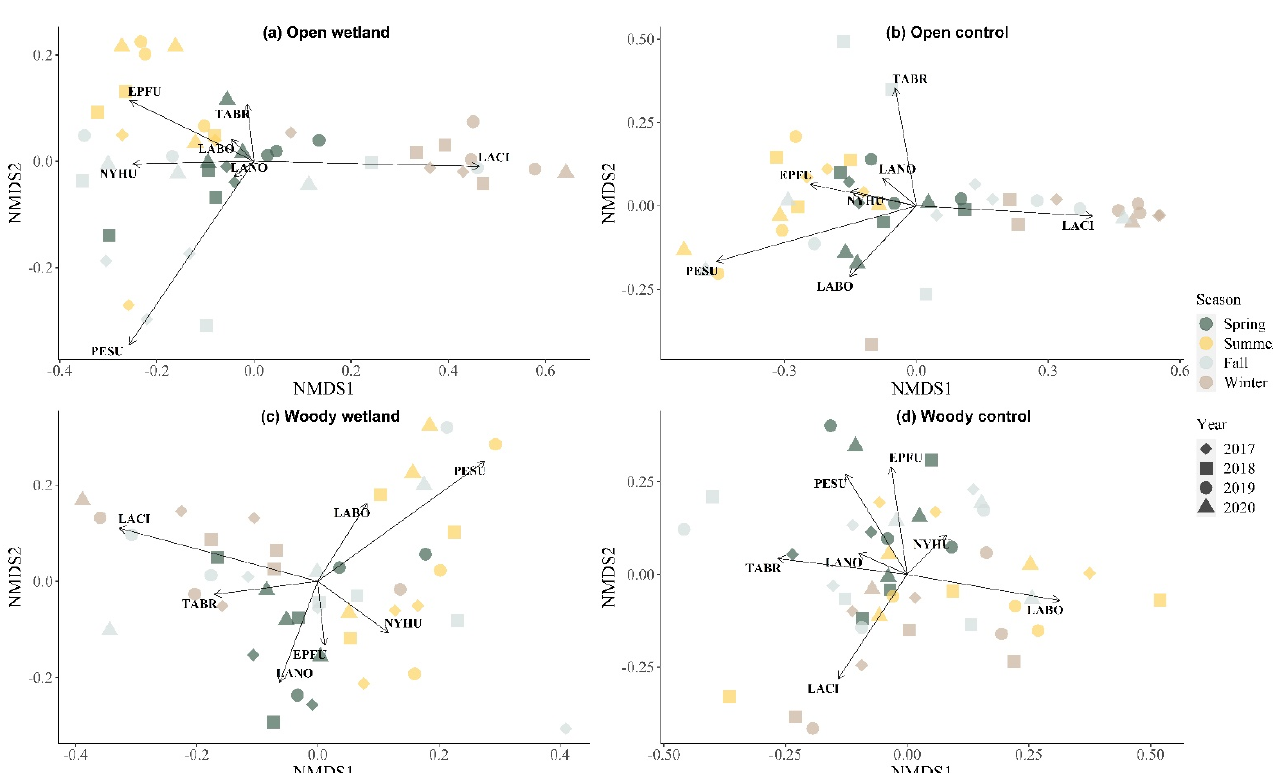
Figure 5. NMSD plots showing monthly bat community composition varied among seasons and across years at four sites in the Peabody Park in Greensboro, North Carolina, USA. Each panel for a site: ( a ) open wetland (stress 0.099); ( b ) open control (stress 0.101); ( c ) woody wetland (stress 0.1554); ( d ) woody control (stress 0.163).